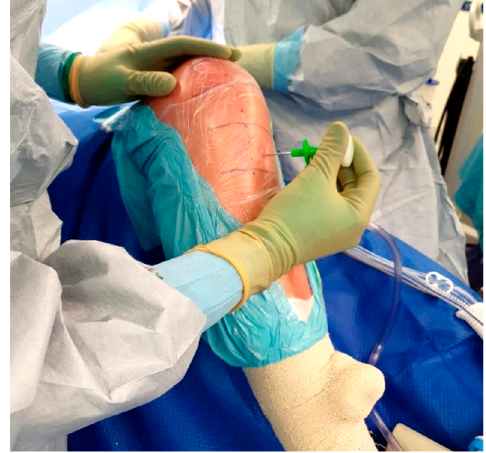
Figure 4. Manual IO insertion.